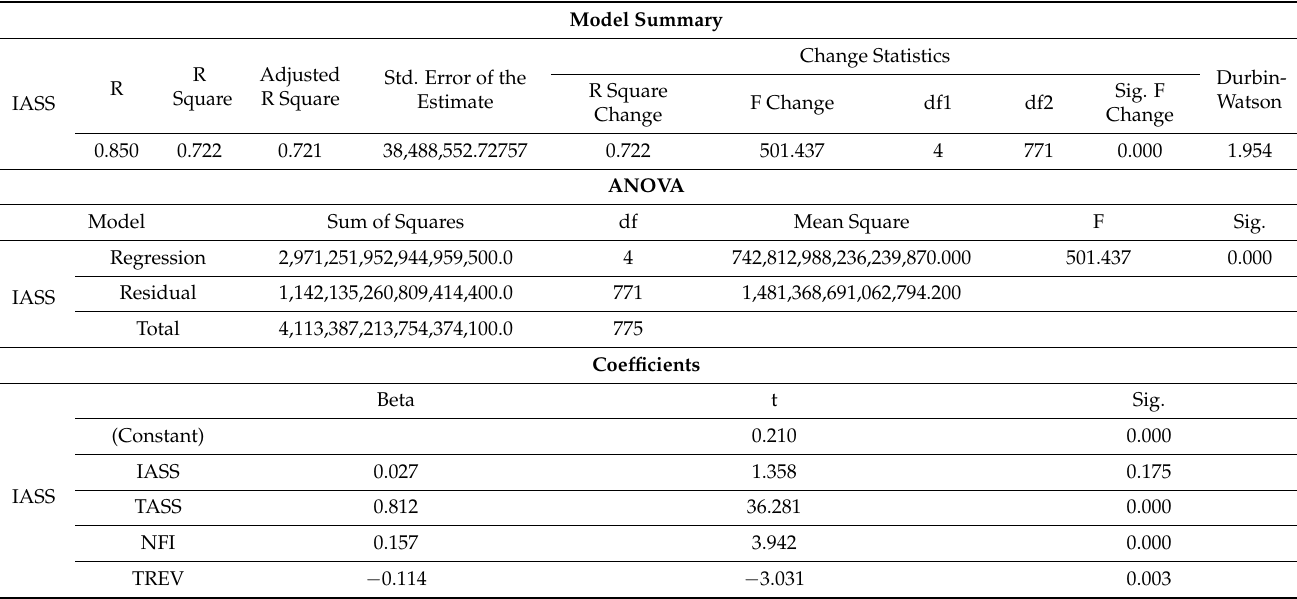
Table 11. Multiple regression analysis for factor